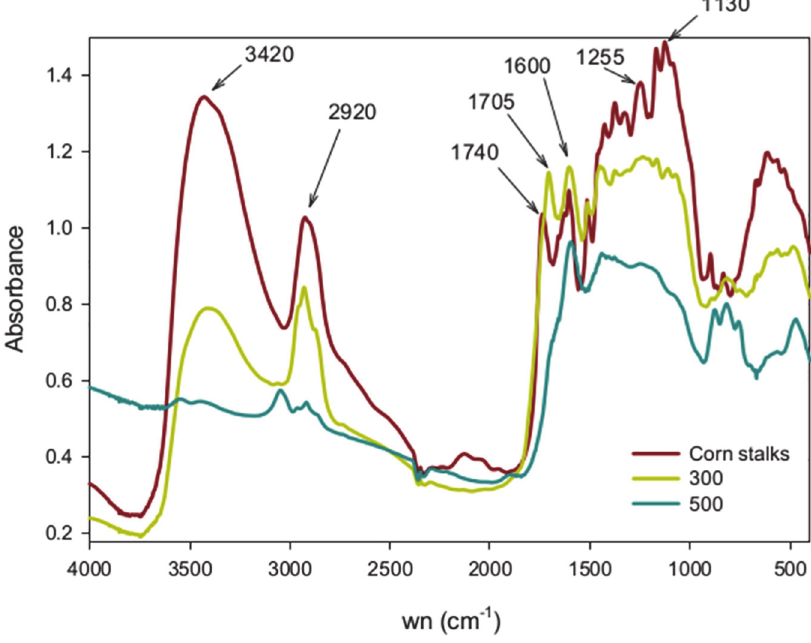
doi:10.1371/journal.pone.0121006.g001